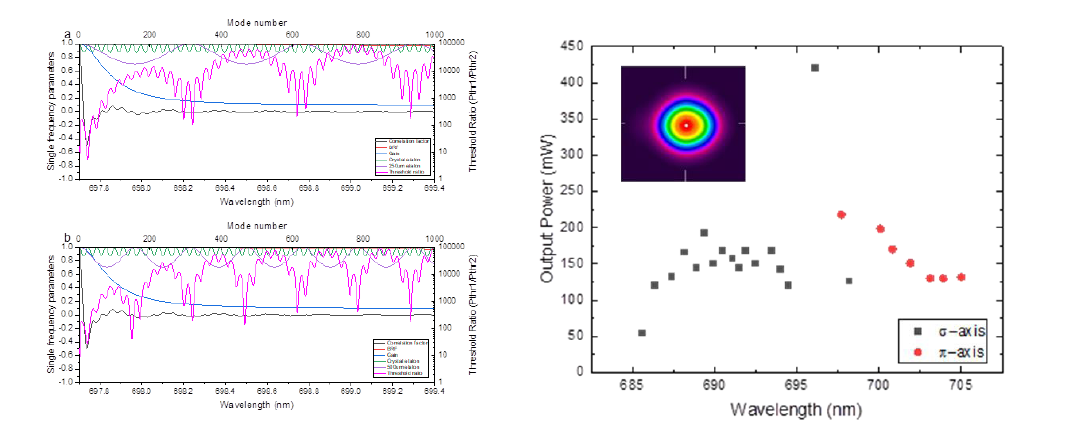
Fig. 1 (left) Analysis of the frequency selective components used to achieve singe-frequency operation and the threshold ratio of the second longitudinal mode compared to the first. (right) measured single-frequency power with beam quality measurement inset (M2